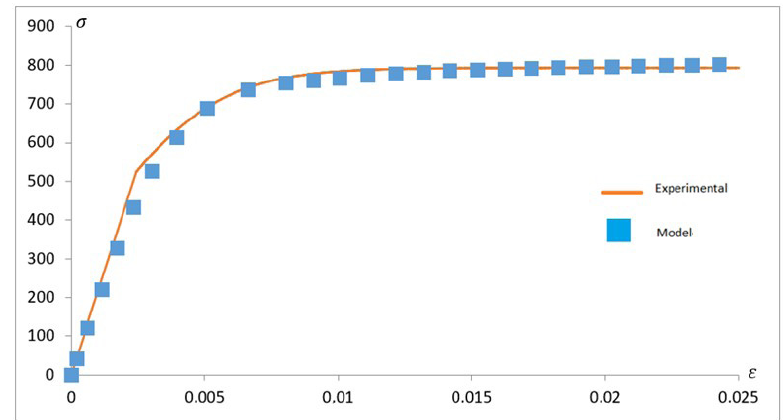
Figure 14. Comparative stress curve (MPa) - strain (mm / mm) -